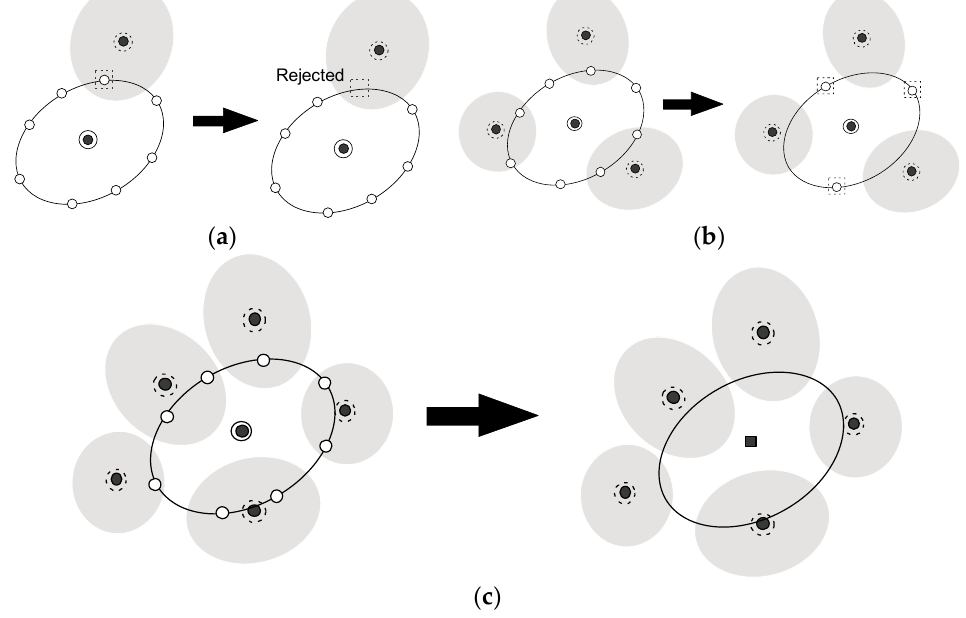
Figure 3. ( a ) If a candidate point is close enough to the sampled window, the candidate point will be rejected. For details, see text. ( b ) The pruning process in step (3): the white circles encircled by dotted squares remain as candidate points for the child point that will be determined in step (4). ( c ) The case that all the child points are rejected: we will go back to step (1) for this case.